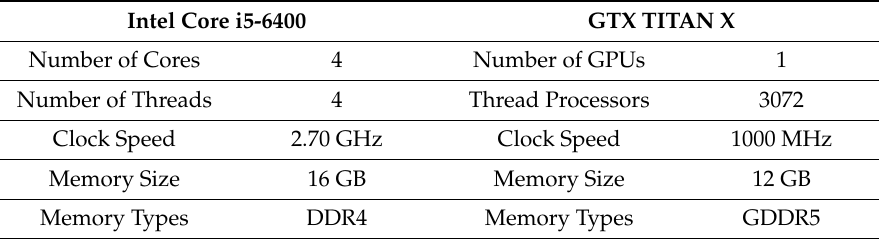
Table 7. Specifications of host and device machines of TITAN X